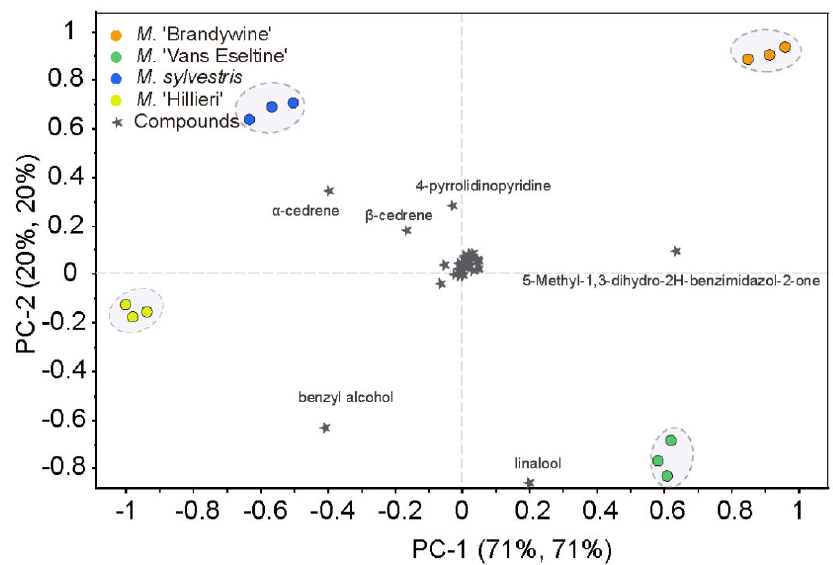
Figure 4. PCA biplot based on the scent compounds of the flowers of the four Malus taxa.